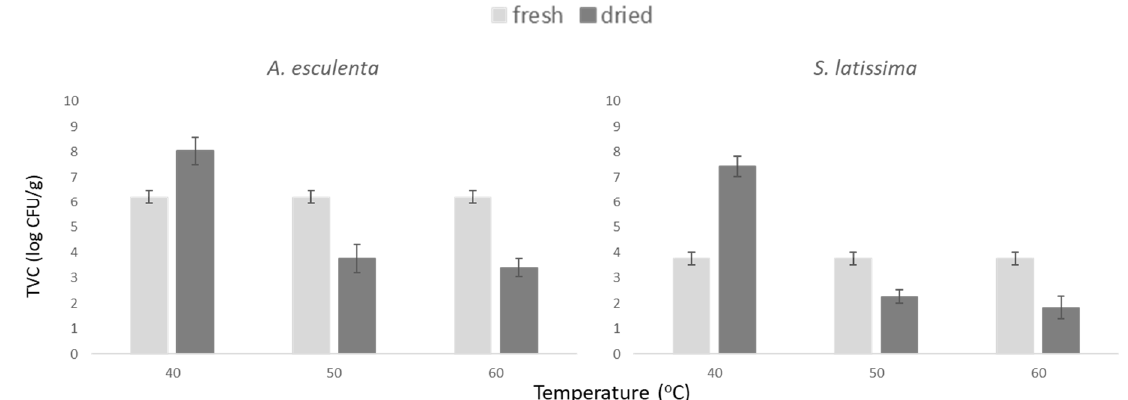
Figure 3. Effect of different drying temperatures on total aerobe (TVC) populations in seaweeds A. esculenta and S. latissima.